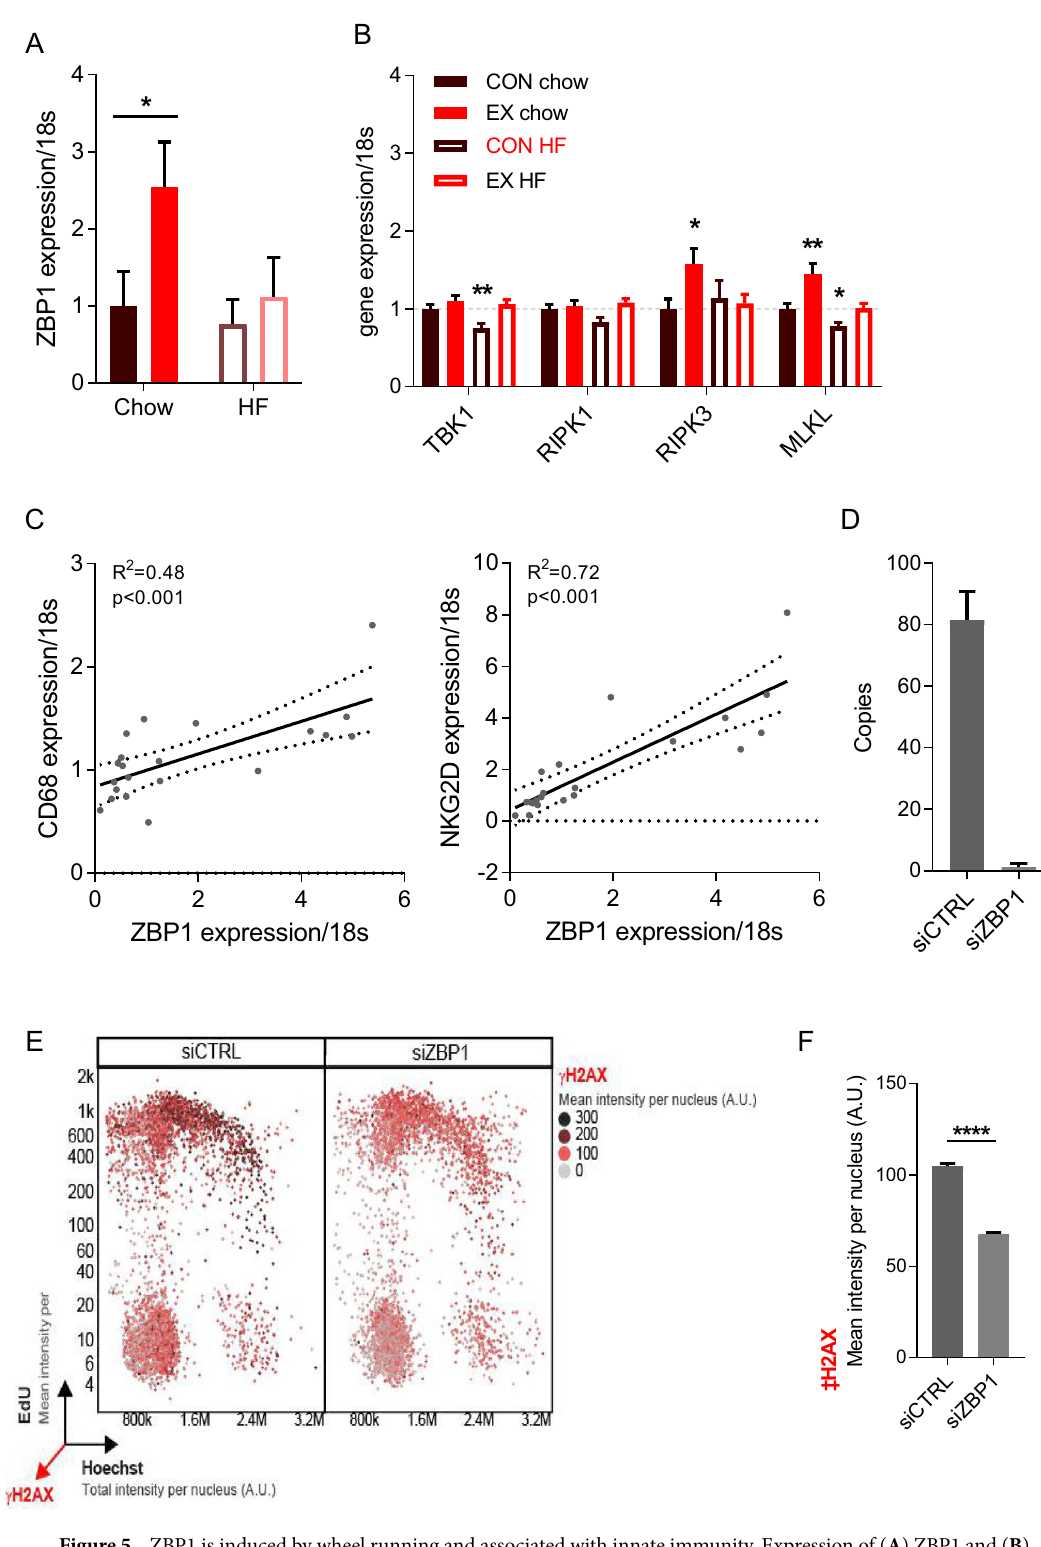
Figure 5. ZBP1 is induced by wheel running and associated with innate immunity. Expression of ( A ) ZBP1 and ( B ) ZBP1-related genes in B16 tumors from mice randomized to control (CON) or 6 weeks of wheel running (EX), and further randomized to chow or high-fat feeding (0) (n = 9–12, study design 1). ( C ) Association between intratumoral ZBP1 expression and markers of innate immune cells, i.e. CD68 and NKG2D. ( D ) Verification of ZBP1 knock-down (siZBP1) after siRNA transfection in B16 cells. ( E ) High-content imaging of cell cycle distribution in ZBP1 KO B16 cells obtained with quantitative image-based cytometry (QIBC). The intensity of the red color depicts the levels of γH2AX expression. ( F ) Quantification of the γH2AX impaired expression upon ZBP1 silencing. Statistical significance was determined by 2-way ANOVA with Tukey’s post hoc test, multiple t -testing, linear regression analyses, and Mann– Whitney tests. Individual stars indicate difference from the CON chow group. * p < 0.05, ** p < 0.01, **** p <